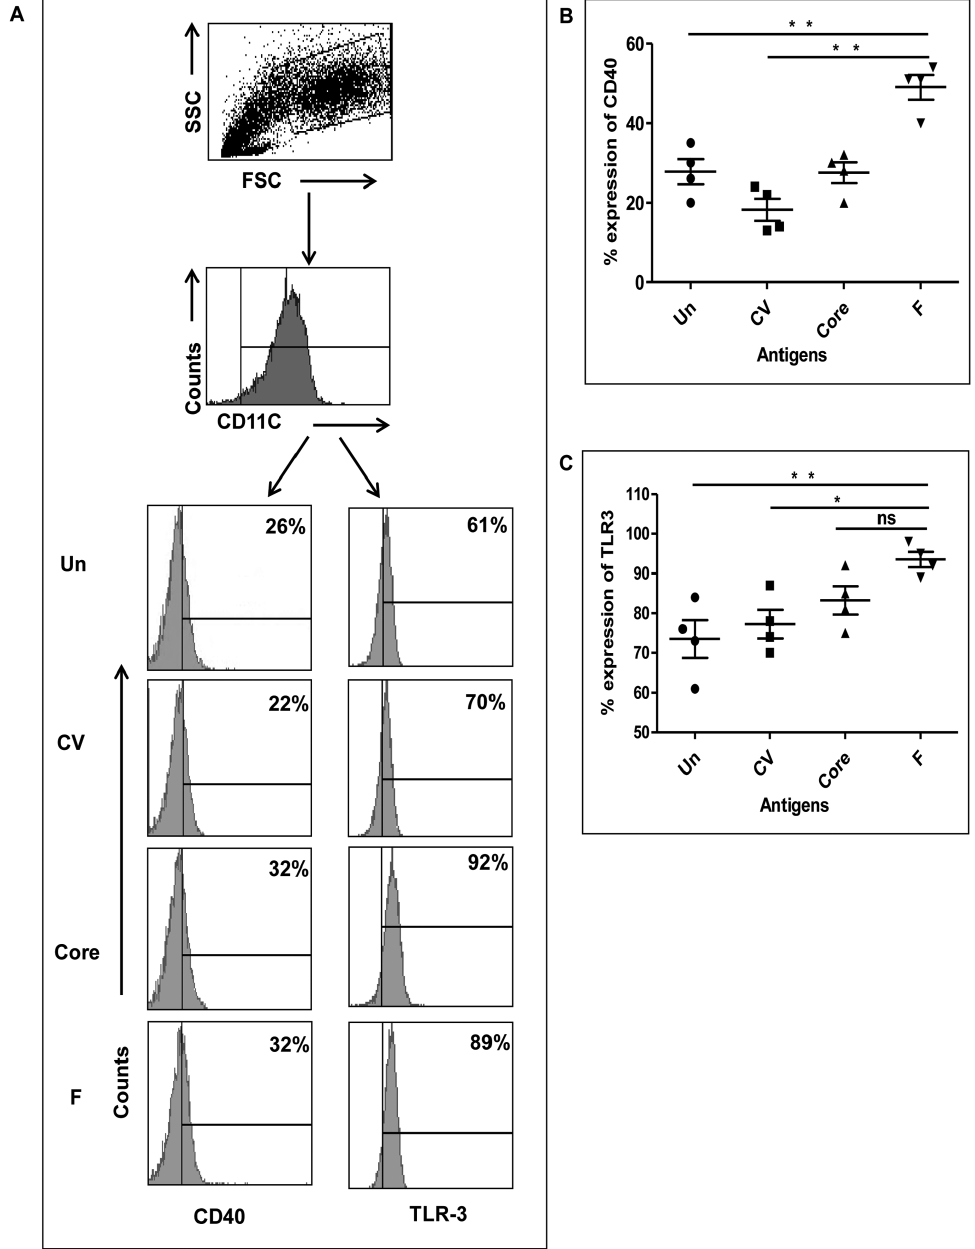
Figure 2. Expression of CD-40 and TLR-3 on DCs expressing F or core protein. DCs were infected with adenovirus containing HCV-derived F or core antigen. After 48 hours of infection, DCs were harvested and stained with antibodies against CD-40 (A, left panel, and B) and TLR-3 (A, right panel, and C). Data shown in panel A are representative of 4 repeated experiments and panels B and C show statistical data from four cumulative